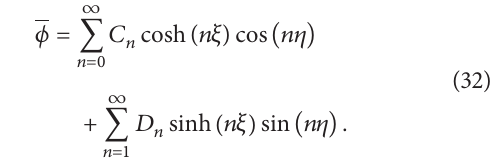
Figure 3: Diagram of the main matrix of the algebraic equation